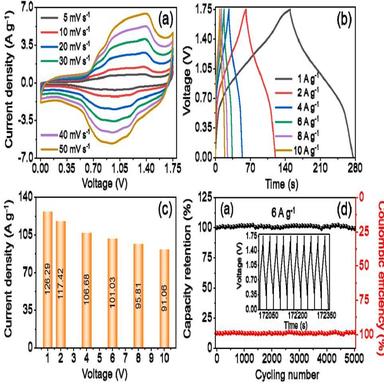
(a) The CV curves and (b) GCD curves of MnCo2O4.5 NSs//AC HSC, (c) the rate performance of MnCo2O4.5 NSs//AC HSC, and (d) the cycling performance and Coulombic efficiency of MnCo2O4.5 NSs//AC HSC over 5000 cycles at 6 A g− 1 . The inset of (d) showed the last 10 GCD curves.